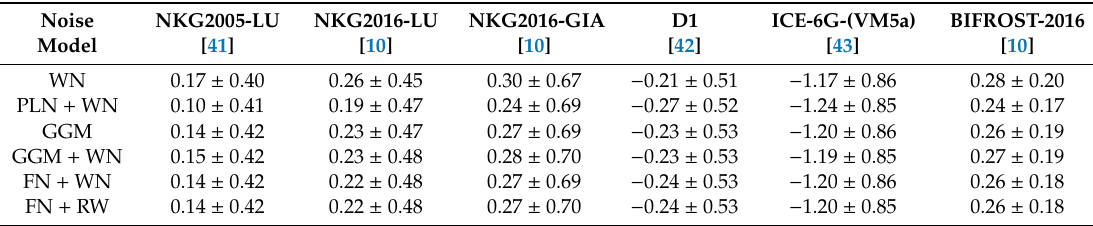
Figure 10. Velocity uncertainty di ff erences (mm / yr) of BERN_2 solution between selected noise models. The lines represent the median, the boxes represent 50% of the values, and the whiskers extend to the highest and lowest values (excluding outliers); the box length is the interquartile range. Table 6. The mean and standard deviation in mm / yr of the Up velocity residuals from di ff erent LU and GIA models based on the solution BERN_2.